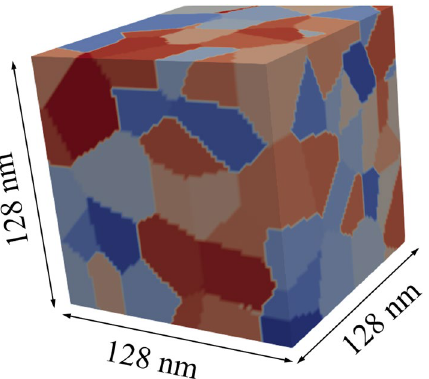
Figure 1. Exemplary polycrystalline NdFeB cuboid of 25.9 nm average grain size with grains indicated by different colors. This figure was created with the open source software ParaView (http://www.parav